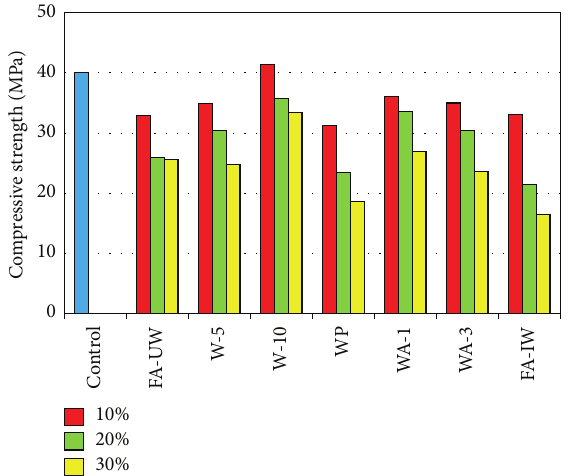
Figure 2: Compressive strength of mortars containing treated ashes as SCM.